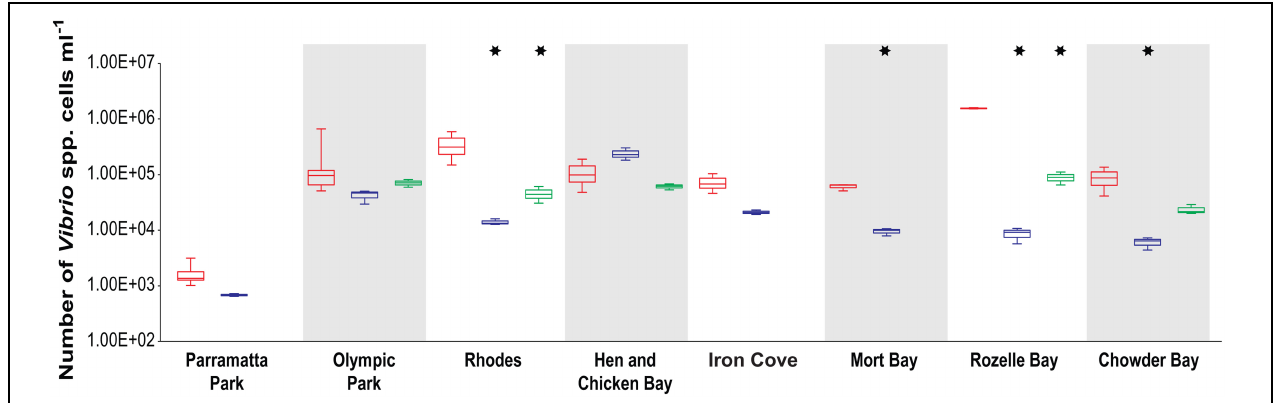
FIGURE 2 | Total Vibrio abundance (mL − 1 ) in Sydney Harbour determined by quantitative PCR. Red boxplots denote summer (March) samples, and blue and green boxplots denote winter [June and August (only at five location), respectively] samples. Asterisks indicate a significant difference between summer–winter